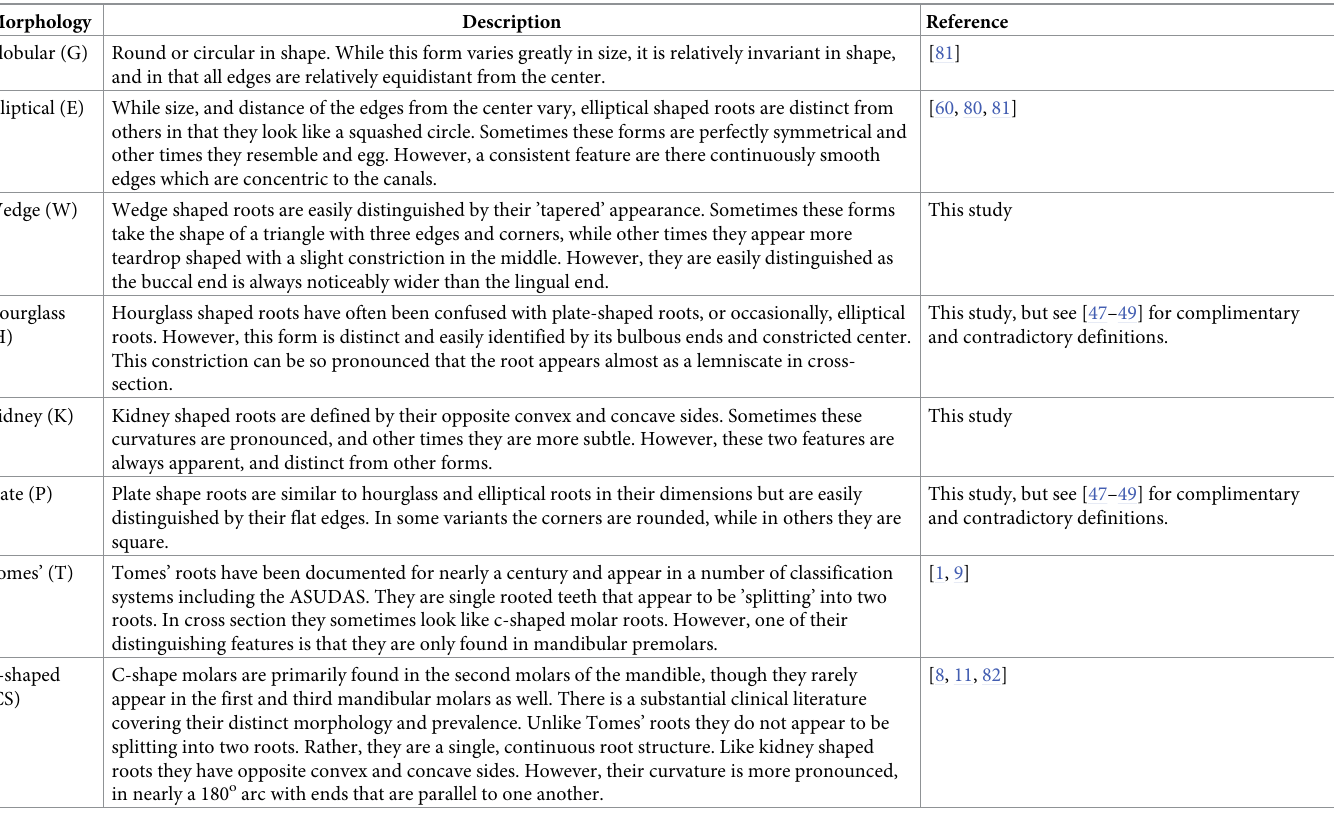
Table 6. Description of external tooth root morphologies at the